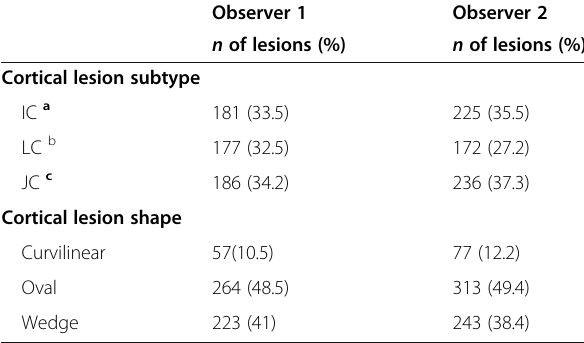
Table 2 MRI (DIR sequence) findings of the studied group as noted by both